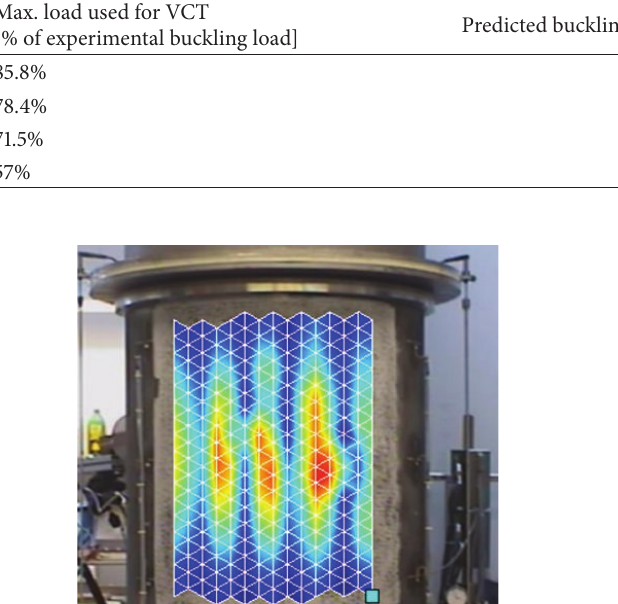
Table 10: Buckling load prediction using the VCT approach for different loading ranges on SST-1 cylinder. Max. load used for VCT [ % of experimental buckling load ]